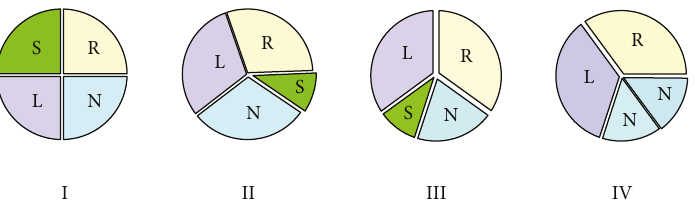
Figure 3: Nakamura et al. classi fi cation of quadricuspid aortic valve. L = left coronary cusp; N = noncoronary cusp; R = right coronary cusp; S = supernumerary